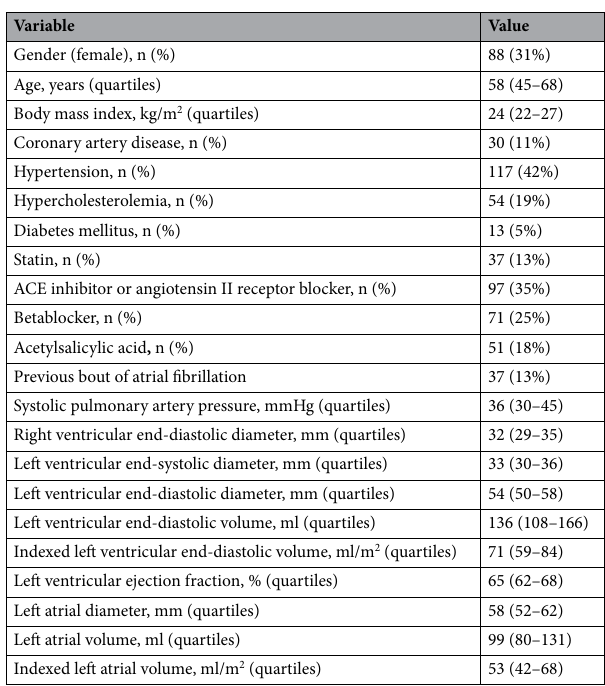
Table 1. Baseline patient characteristics. Median (quartiles) and count (%).